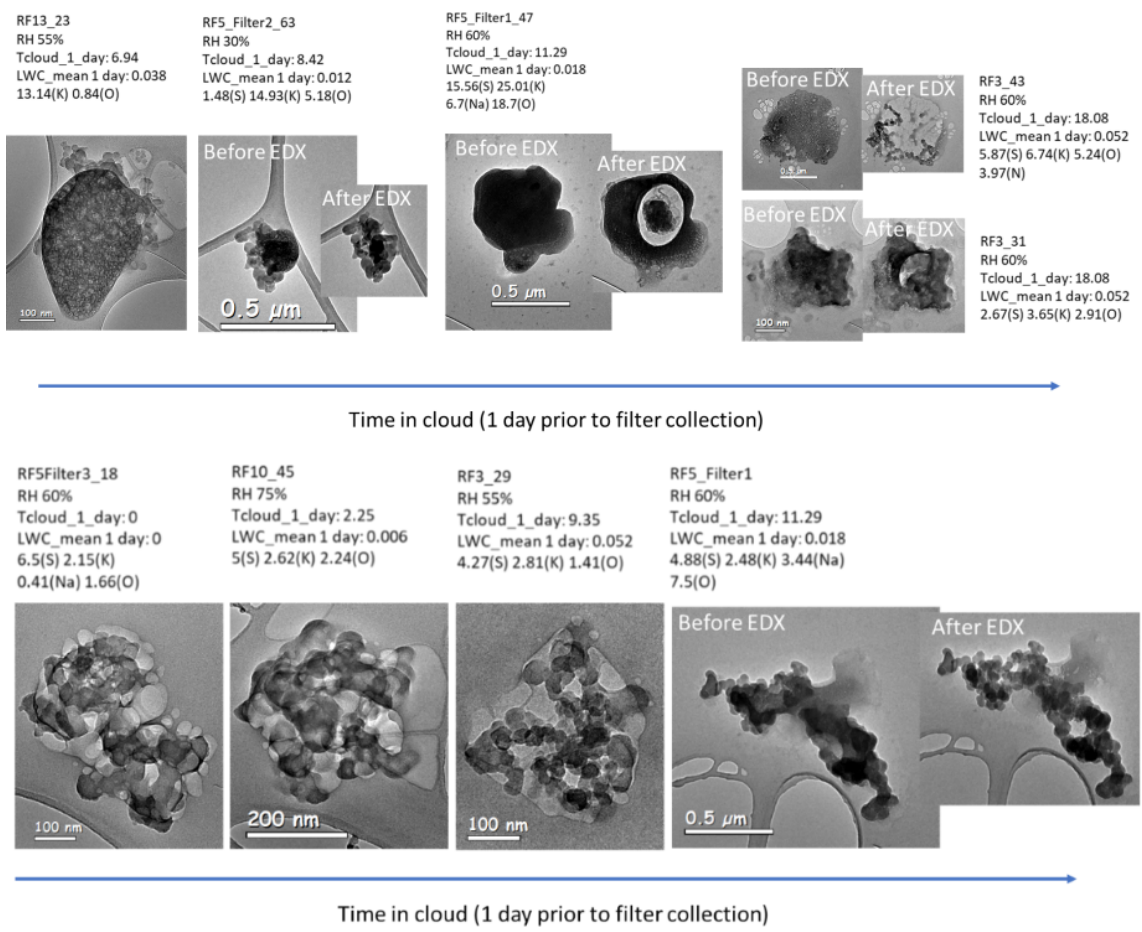
Figure 9. Potassium salt mixed with BC (top panel) and sulfur/organic material and BC (bottom panel) as a function of time in cloud in the 24h prior to filter